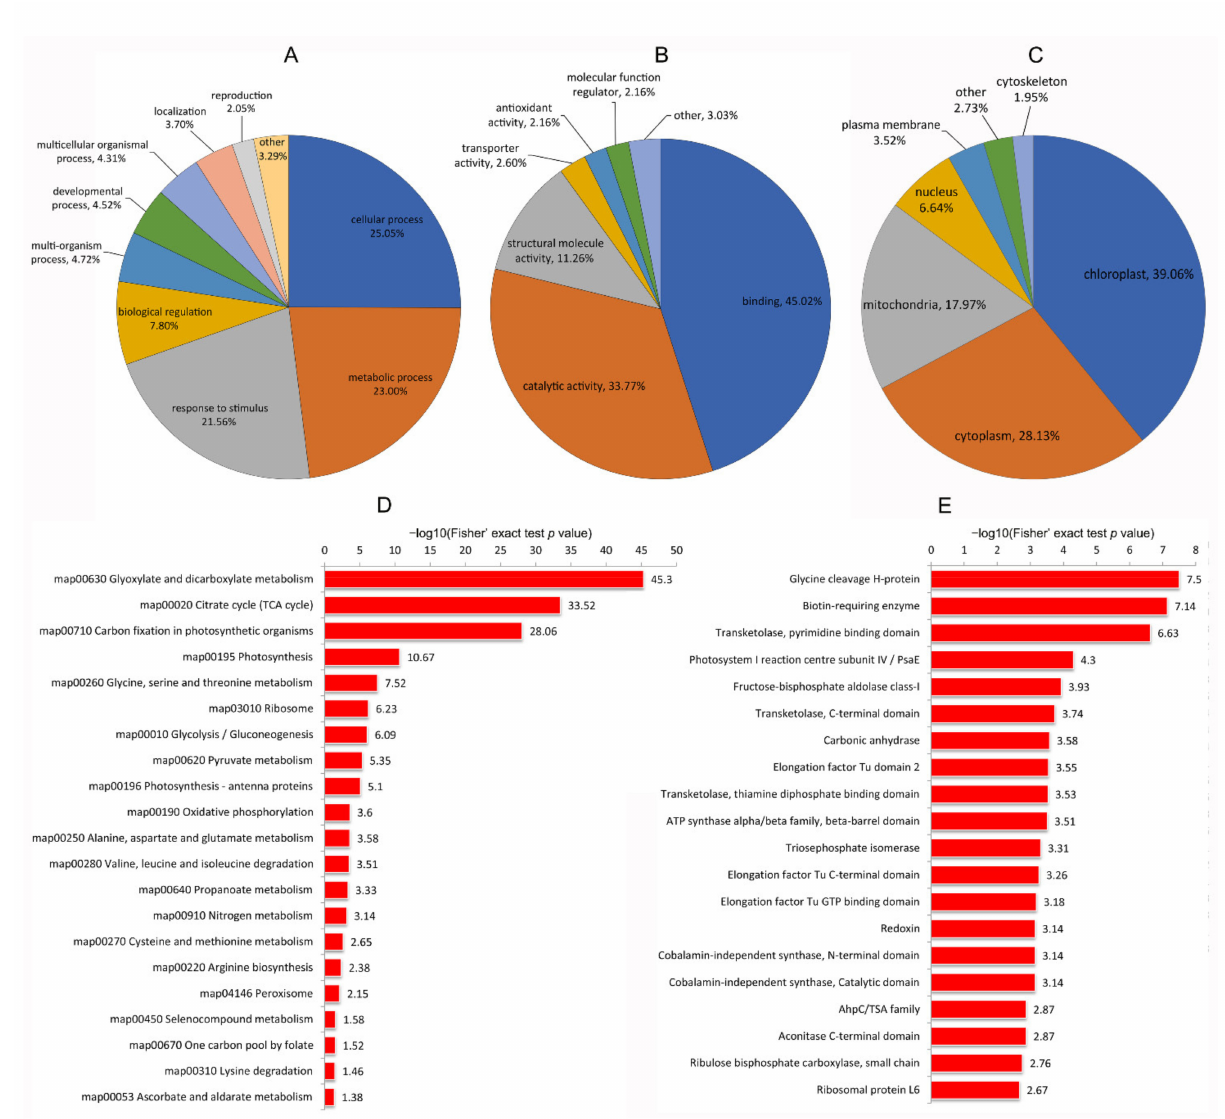
Figure 3. Classification and subcellular location analysis of succinylated proteins identified in the shoots of turnip seedlings. ( A ) GO-based biological process classification of succinylated proteins; ( B ) GO-based molecular function classification of succinylated proteins; ( C ) Subcellular location analysis of succinylated proteins; ( D ) Enriched KEGG pathways of succinylated proteins; ( E ) Top 20 enriched domains of succinylated